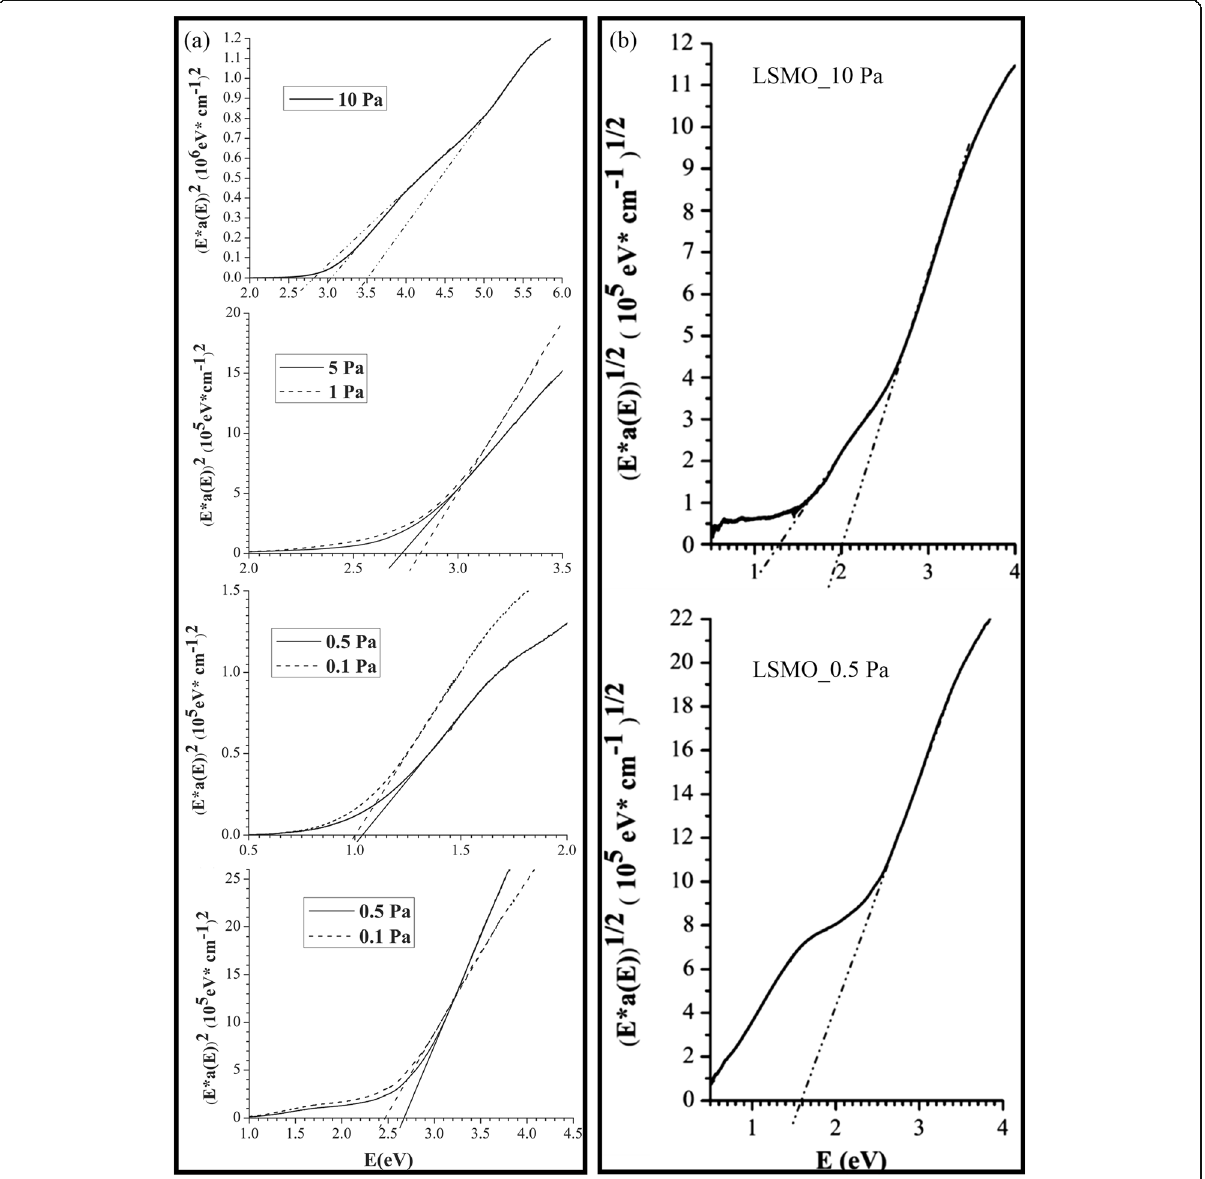
Fig. 39 a Plots of ( E α ( E )) 2 versus photon energy ( E ) of the LSMO films grown under different oxygen pressures. The direct transitions are identified by extrapolation of the straight line portions to energy axis. b Plots of ( E α ( E )) 1/2 versus photon energy ( E ) of the LSMO films grown under oxygen pressures of 10 Pa and 0.5 Pa. Linear regions occur that are indicative of indirect transitions in the LSMO films grown under oxygen pressure of 10 and the amorphous nature for LSMO films grown under oxygen pressure of 0.5 Pa. Reproduced with permission of